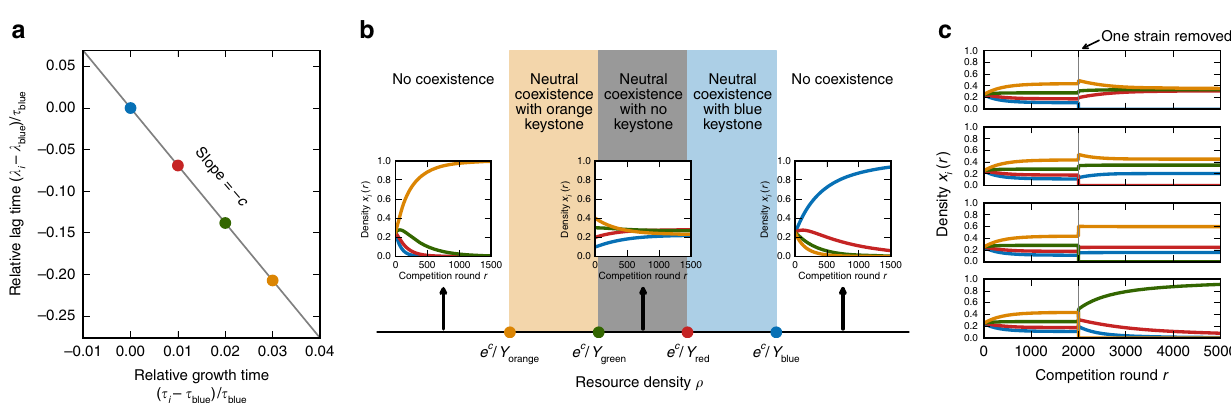
Fig. 3 Neutral coexistence of multiple strains on a single resource. a Lag and growth times of four strains (blue, red, green, orange). For them to neutrally coexist in a community, these traits must have a linear tradeoff with slope − c (Eq. 6). b Diagram of competition outcomes as a function of resource density ρ . Each inset shows the dynamics of the strains ’ densities x r ) over rounds of competition r for a particular value of ρ . All four strains will neutrally coexist if i ( ρ is in the range de fi ned by Eq. 7 (shaded regions). If ρ is in the orange or blue regions, coexistence hinges on a single keystone strain of corresponding color (orange or blue), while if ρ is in the gray region, coexistence is robust to loss of any single strain. c Density dynamics of the same four strains with resource density ρ in the orange region of b , so that the orange strain is the keystone. All four strains coexist together at fi rst, then at competition round 2000 one strain is removed (different in each panel) and the remaining strains are allowed to reach their steady state. See Supplementary Note 8